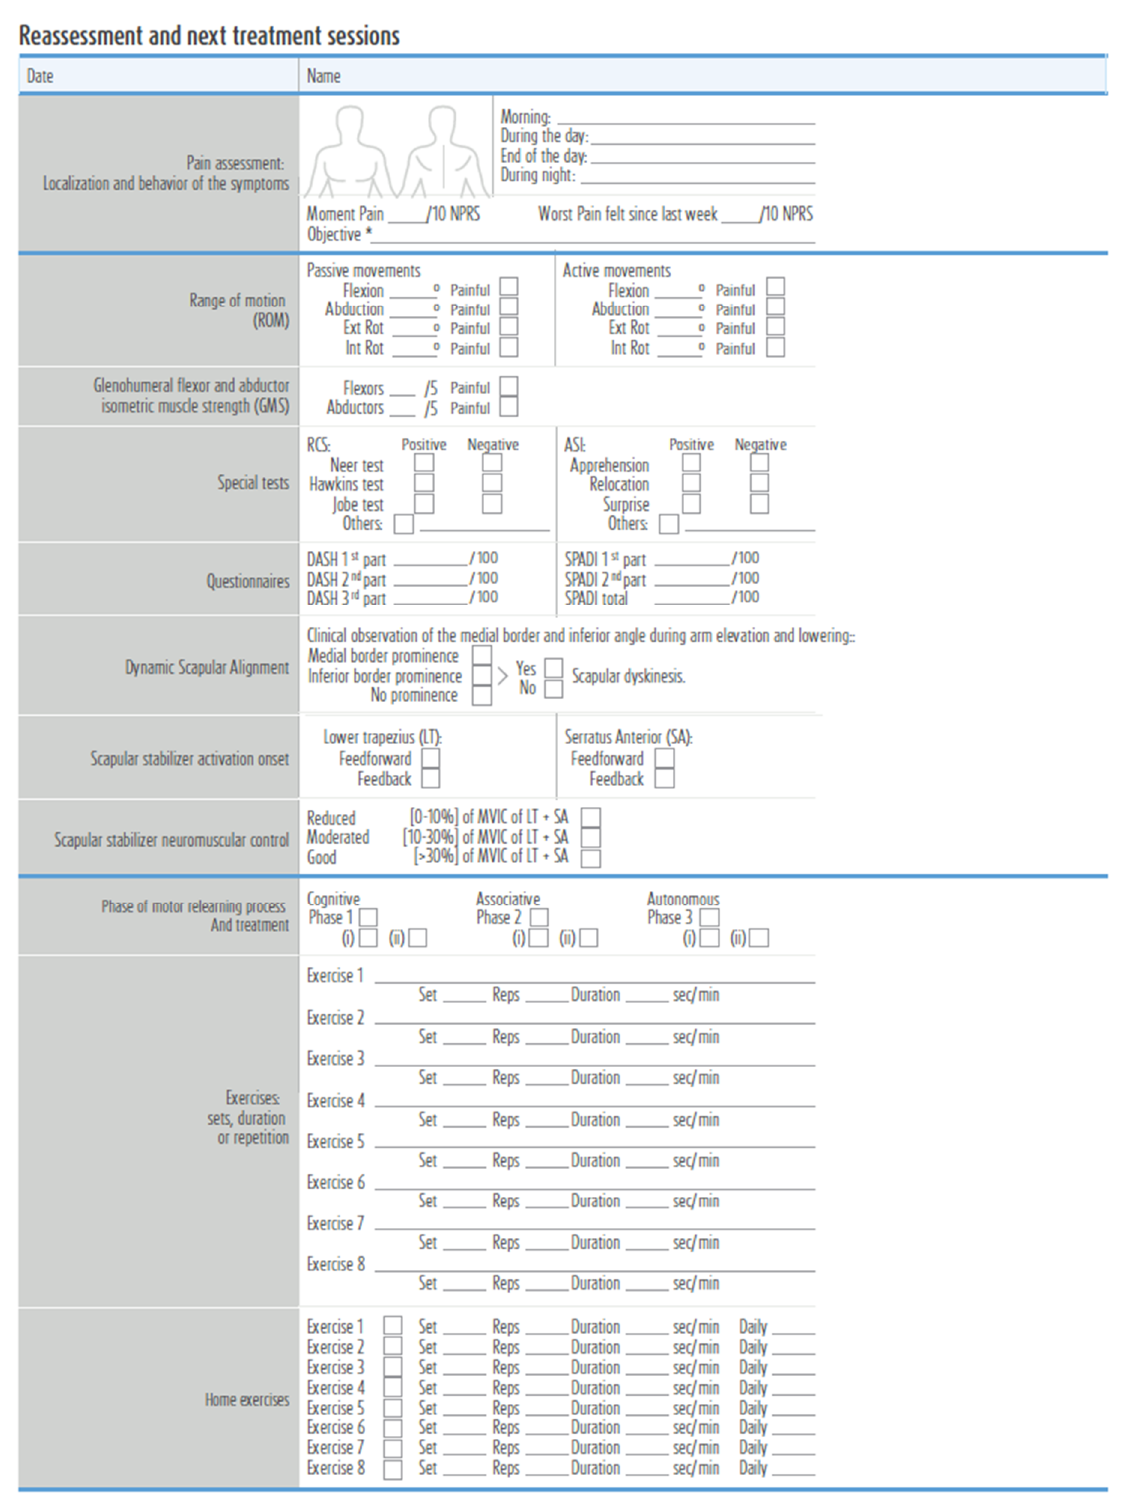
Figure A2. Reassessment and next treatment form.